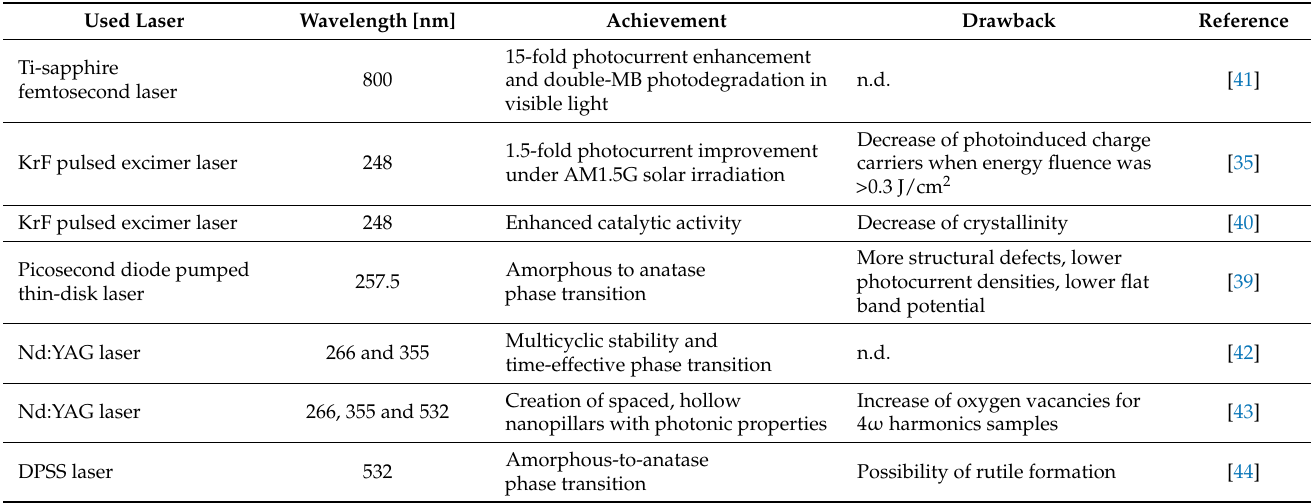
Table 1. Comparison of the selected literature on laser-treated titania